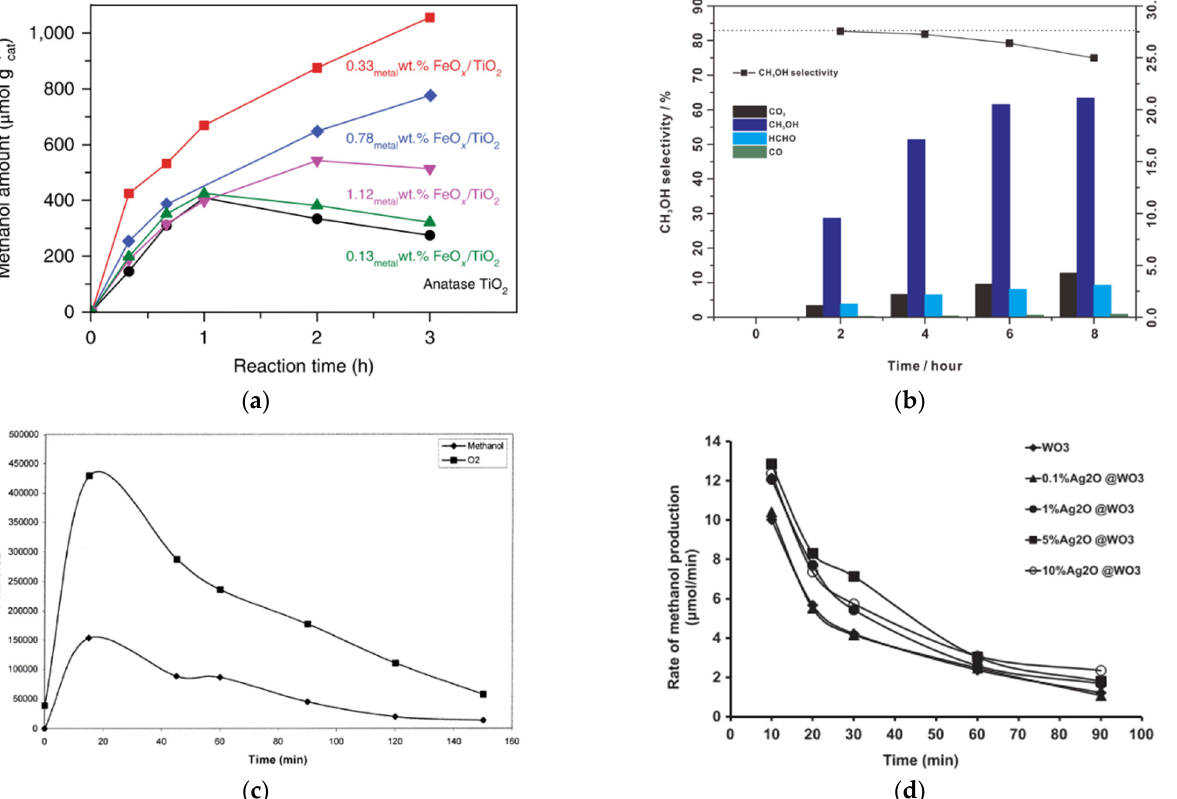
Figure 33. Dependency of time irradiation on production or selectivity of methanol was reported by ( a ) Gondal et al. [29], ( b ) Hameed et al. [32], ( c ) Xie et al. [26], and ( d ) Feng et al. [85]. Reproduced with permission from Gondal et al. Copyright © 2022 Elsevier, Hameed et al. Copyright © 2022 Elsevier, Xie et al. Copyright © 2022 Springer Nature, and Feng et al. Copyright © 2022 Springer Nature.